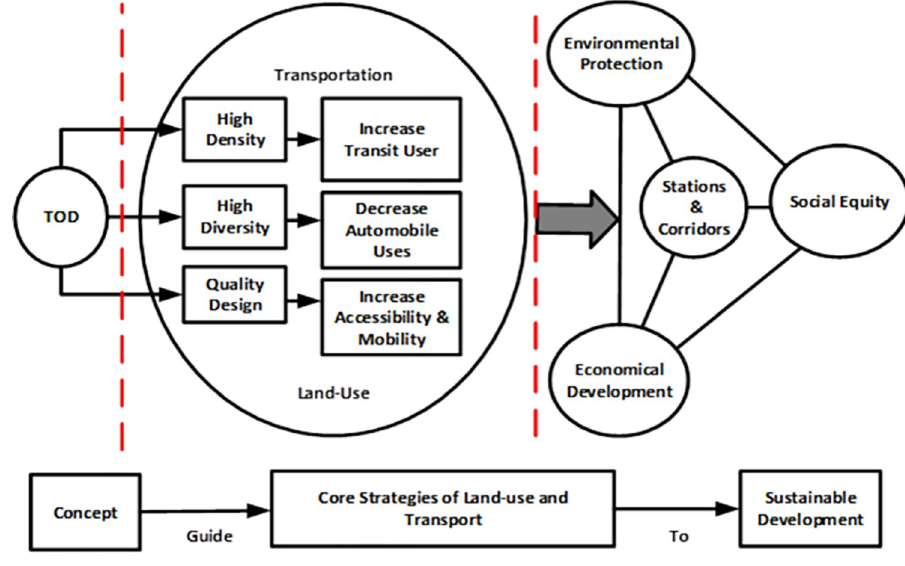
Fig 1. TOD as a sustainable development. Source: